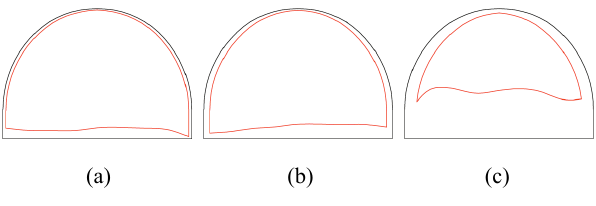
Fig. 6. Maingate D-2 convergence: (a) base on 930 m,